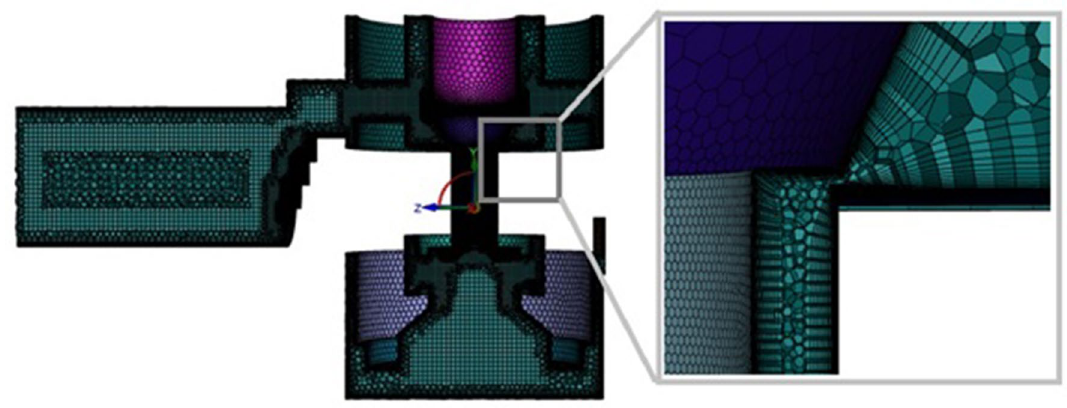
Figure 7. Computational grid—poly-hedral elements for case number 1. [Ansys Fluent 2021 R2 (ANSYS Academic Research Mechanical and CFD): https:// downl oad. ansys. com/ Curre nt% 20Rel ease? relea seno= 2021% 20R2& opera tings ystem= Windo ws%